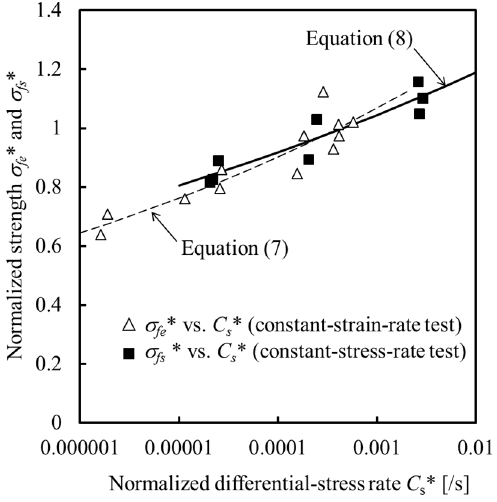
Figure 11. Normalized strengths σ fe * and σ fs * versus normalized differential-stress rate C s * in constant-strain-rate and constant-stress-rate tests.